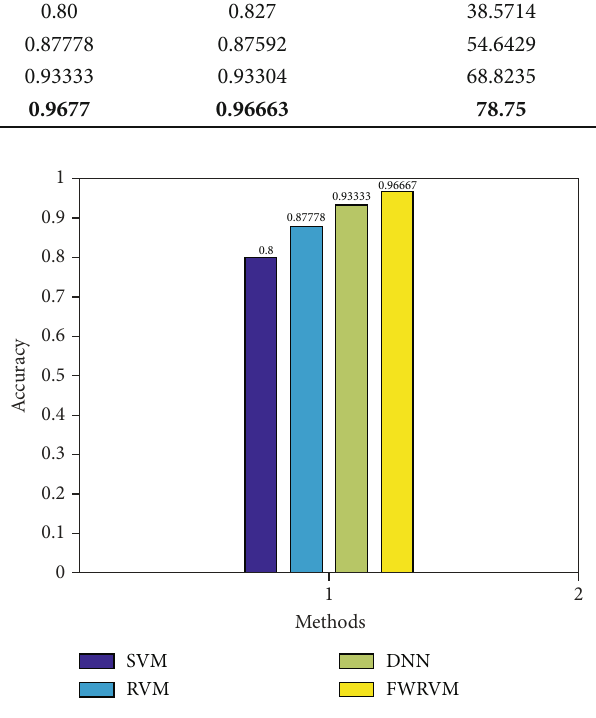
Figure 3: Accuracy